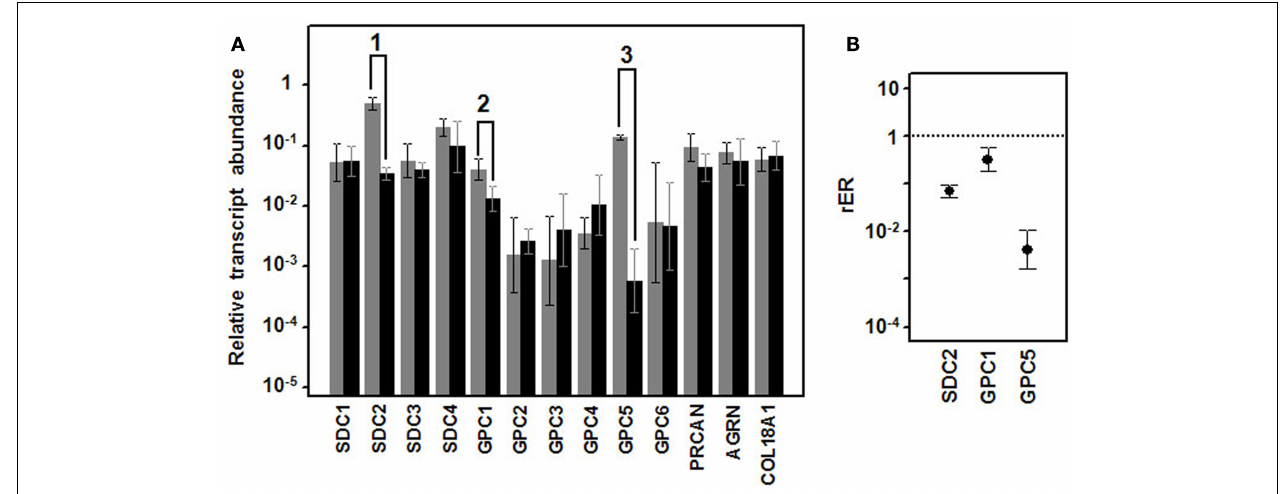
showing significant differences are indicated: 1, p < 0.001; 2, p = 0.018; 3, p = 0.0001. (B) Relative expression ratio of genes that show statistically significant differences in expression in poorly differentiated compared to well-differentiated tumors.Values on the Y axis are represented on a logarithmic